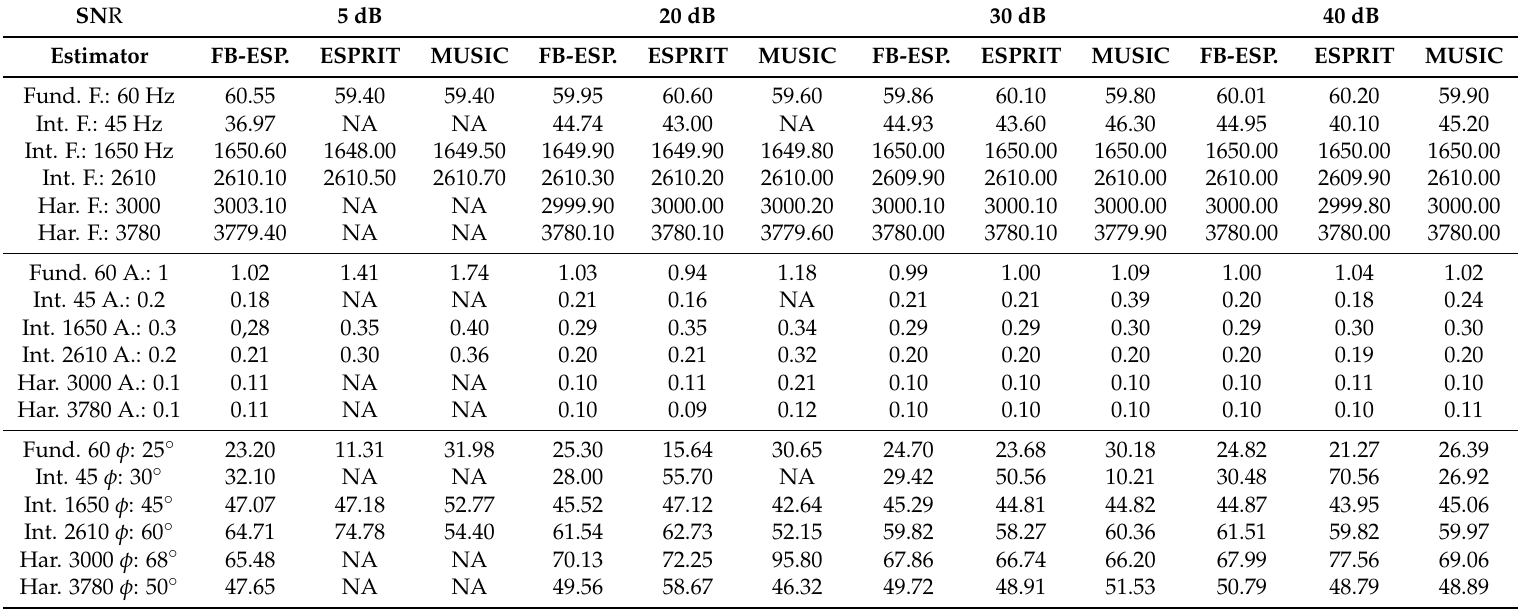
Table 7. Mean signal s 2 ( t ) parameters estimated in 1000 runs by FB-ESPRIT, ESPRIT, and MUSIC at different levels of SNR (5, 20, 30, 40 dB) under contamination by pink